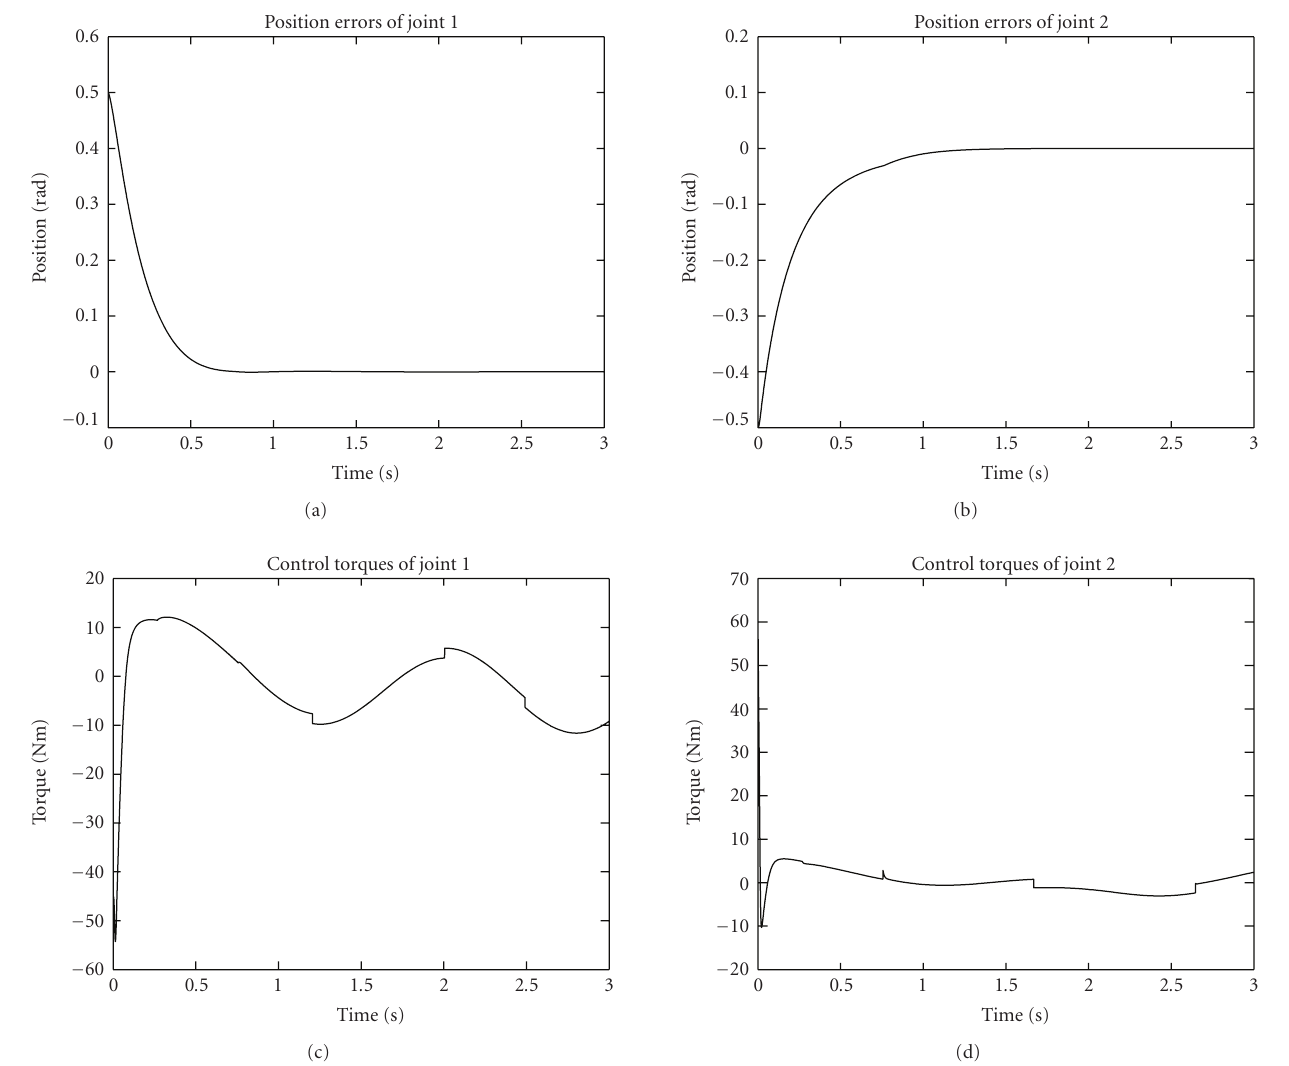
Figure 3: Response using proposed conventional robust control law ( α =